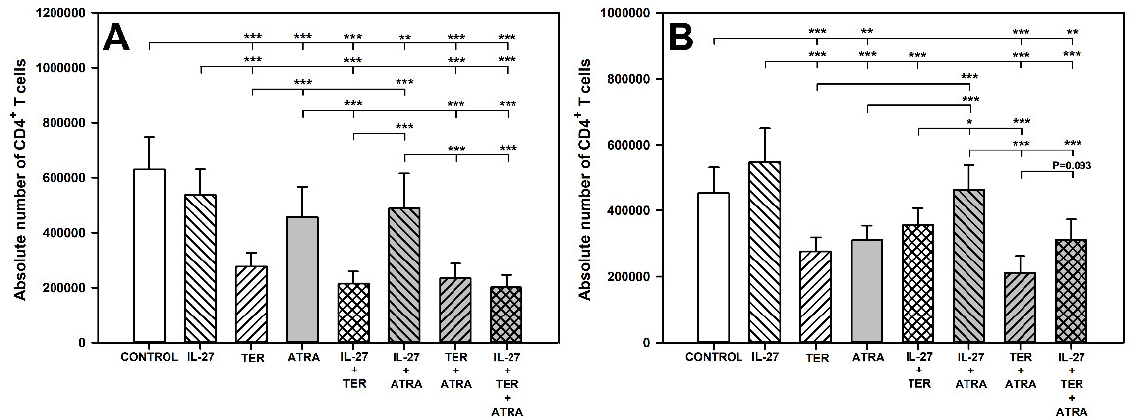
Figure 1. Effect of IL-27, teriflunomide (TER), all-trans-retinoic acid (ATRA), and their combinations on the absolute number of CD4 + T cells under stimulated and unstimulated conditions. The param- eter was determined in cell cultures incubated in the absence (CONTROL) and presence of IL-27 (100 ng/mL), TER (10 − 4 M), and ATRA (10 − 6 M) for 72 h including concomitant stimulation (with IL- 2, anti-CD3, and anti-CD28 and re-stimulation with PMA and ionomycin for the last 5 h before har- vest) ( A ) and for 96 h without stimulation ( B ). The absolute count represents the number of CD4 + T cells per sample well. Results are expressed as the mean (± S.D.) of three independent experiments with four mice per experiment (overall n = 12 ( A ) or n = 8 ( B ), * p < 0.05, ** p < 0.01, *** p < 0.001).